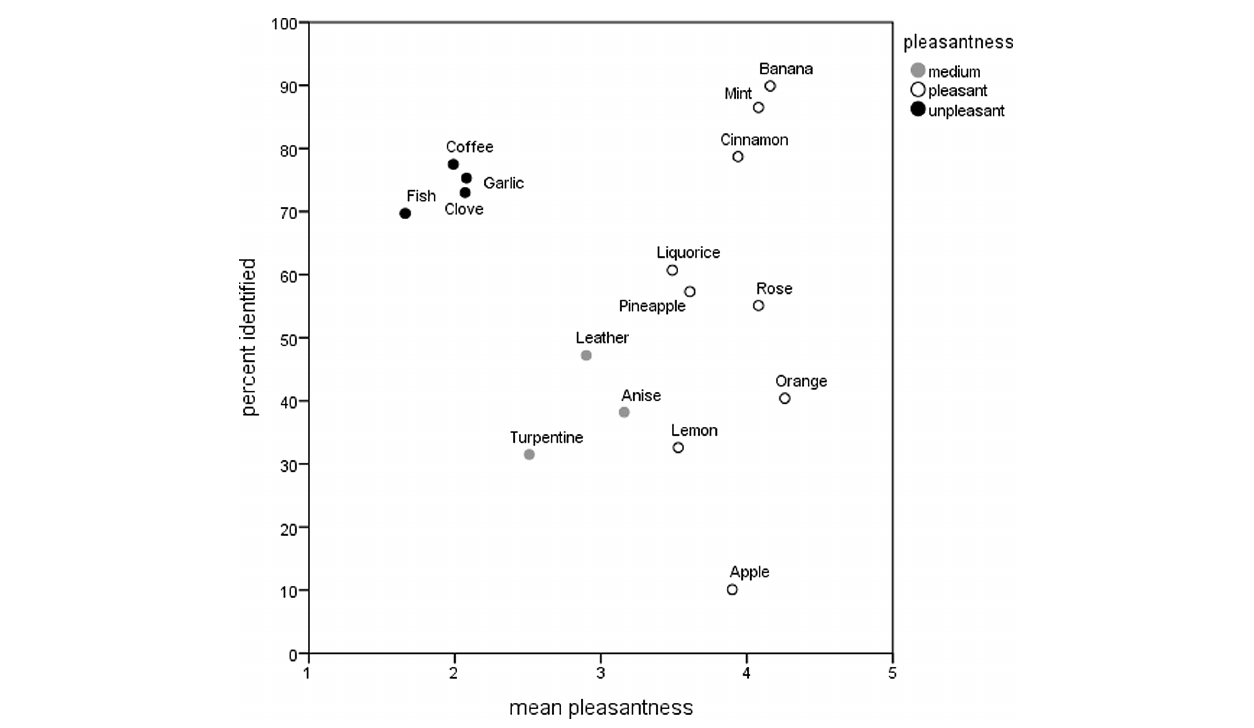
FIGURE 1 | Scatter plot of mean pleasantness ratings and percentages of correct identifications for the 16 odors of the Sniffin’ Sticks odor identification test. The pleasant and unpleasant subsets are given in white and black, respectively, and the medium pleasant odors are given in gray.